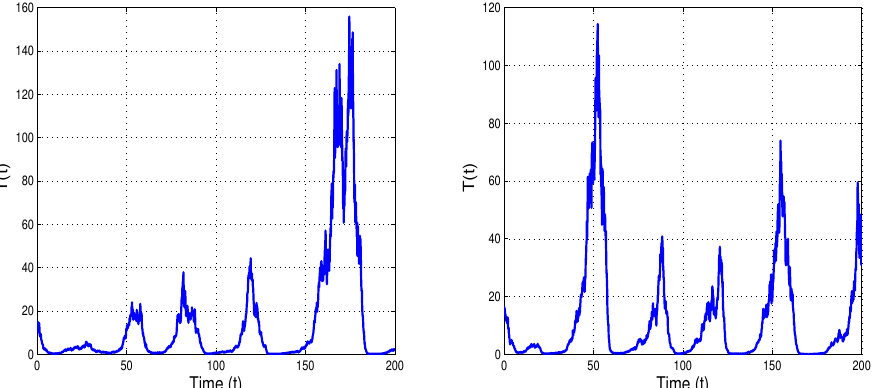
2 ∨ σ 2 ∨ σ 2 = 0.075 > 0. The threshold conditions of unique stationary 2 3 1 2